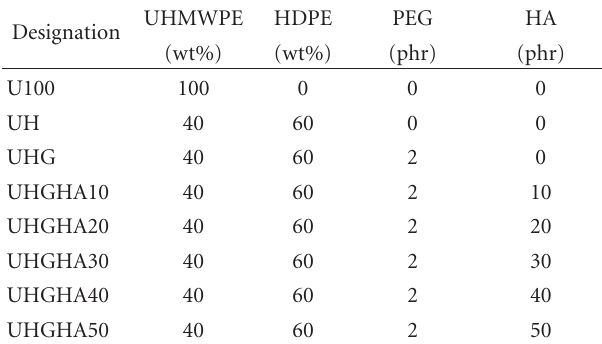
Table 1: Composition of the UHMWPE